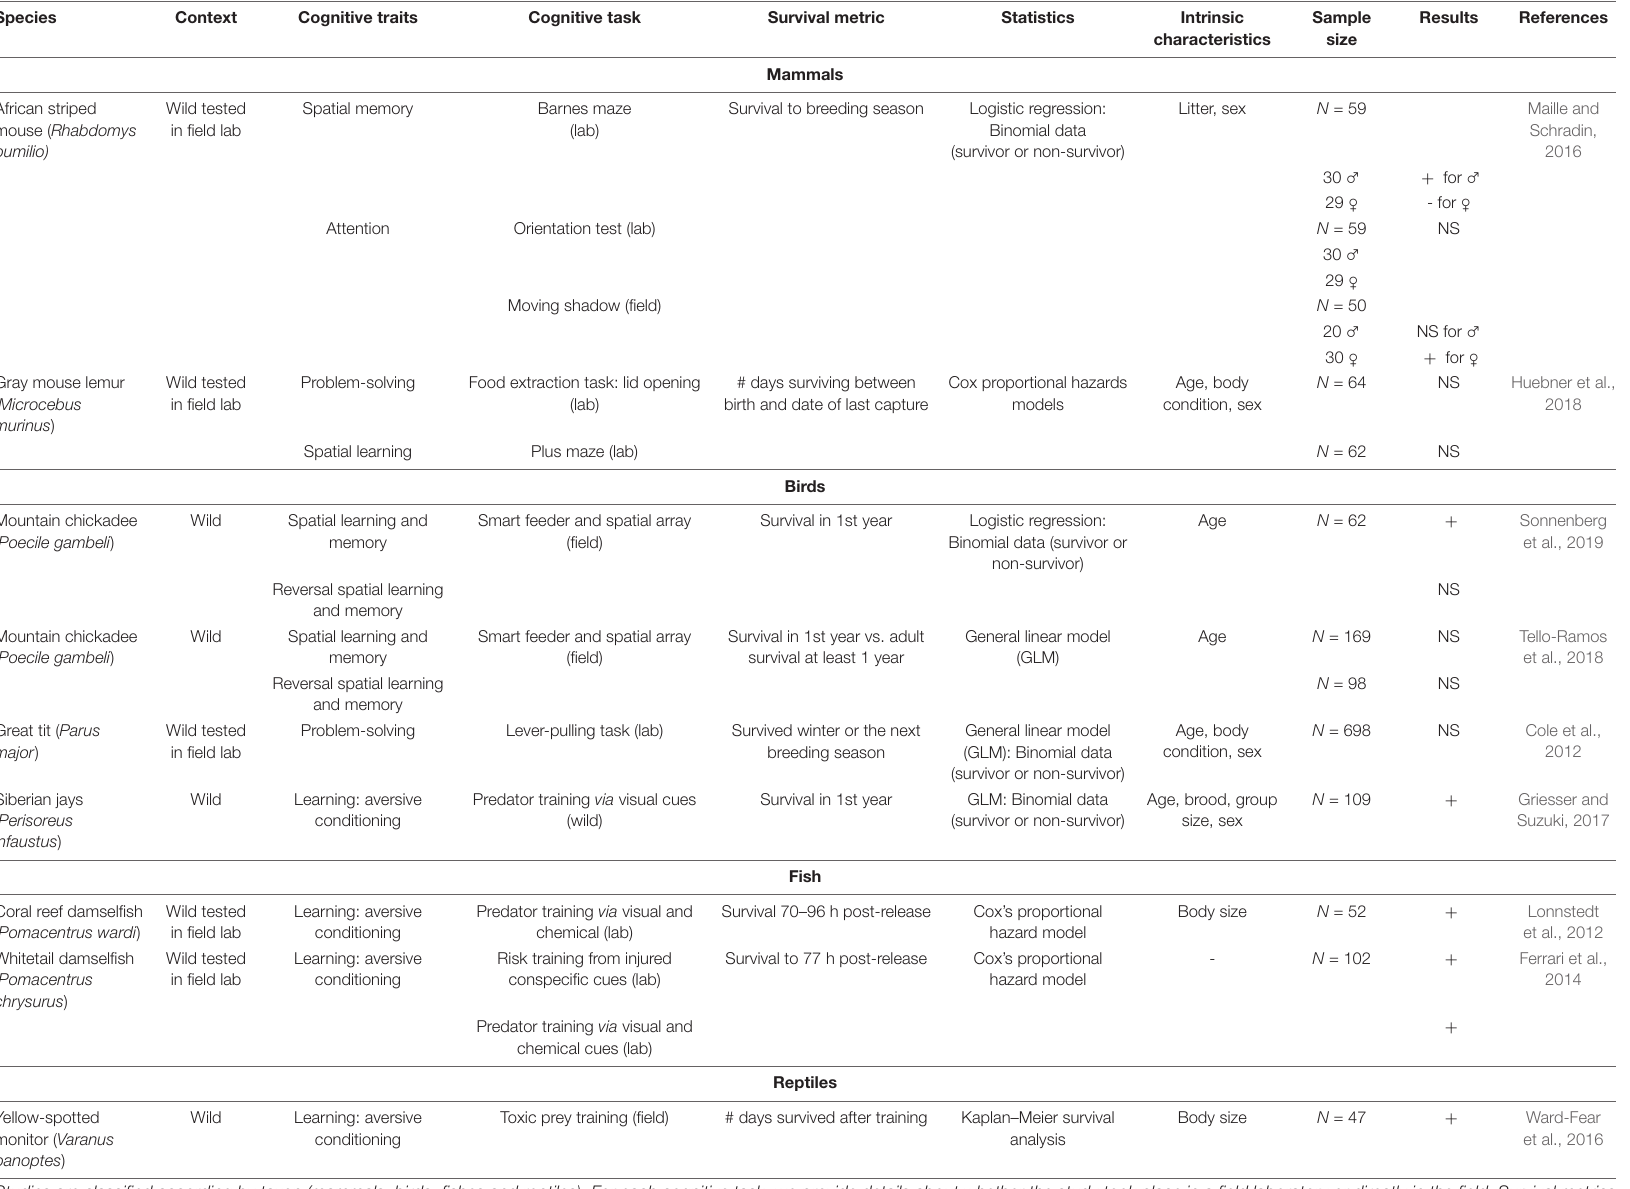
TABLE 1 | Overview of studies linking cognitive performance and survival in free-living animal populations.